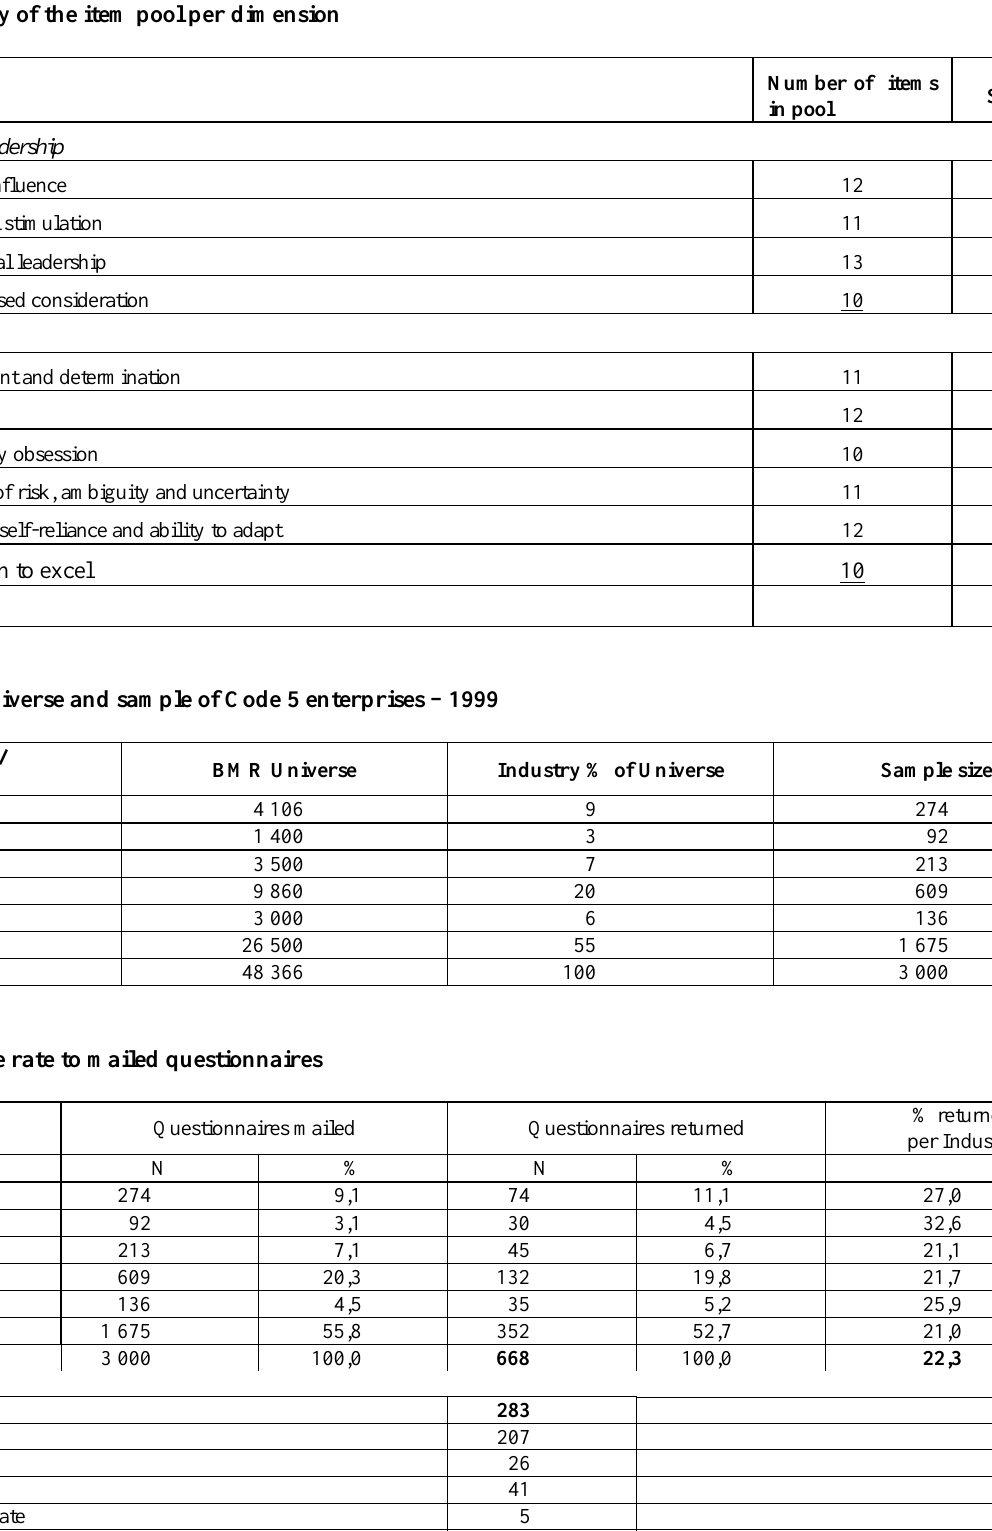
Table 5: Summary of the item pool per dimension Dimension